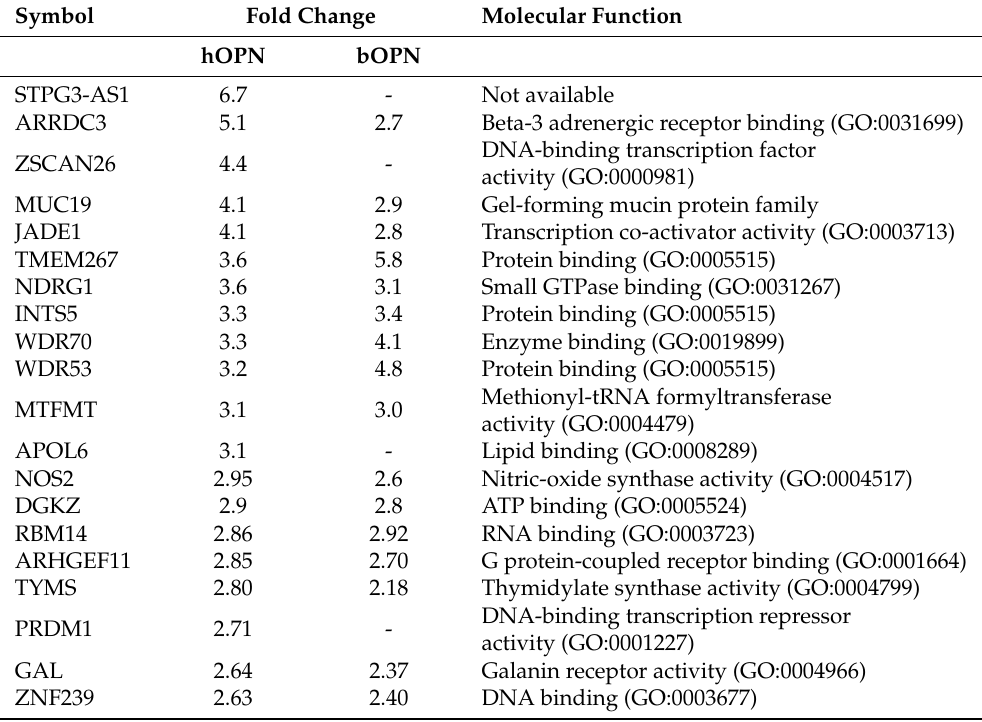
Figure 2. Differentially expressed genes in Caco-2 cells exposed to bovine milk OPN and human milk OPN. The Venn diagram shows the shared and OPN-specific genes. p -adjust <0.05 LCF > |1|. Table 2. Twenty most upregulated differentially expressed genes (by Fold change)( p -adjust